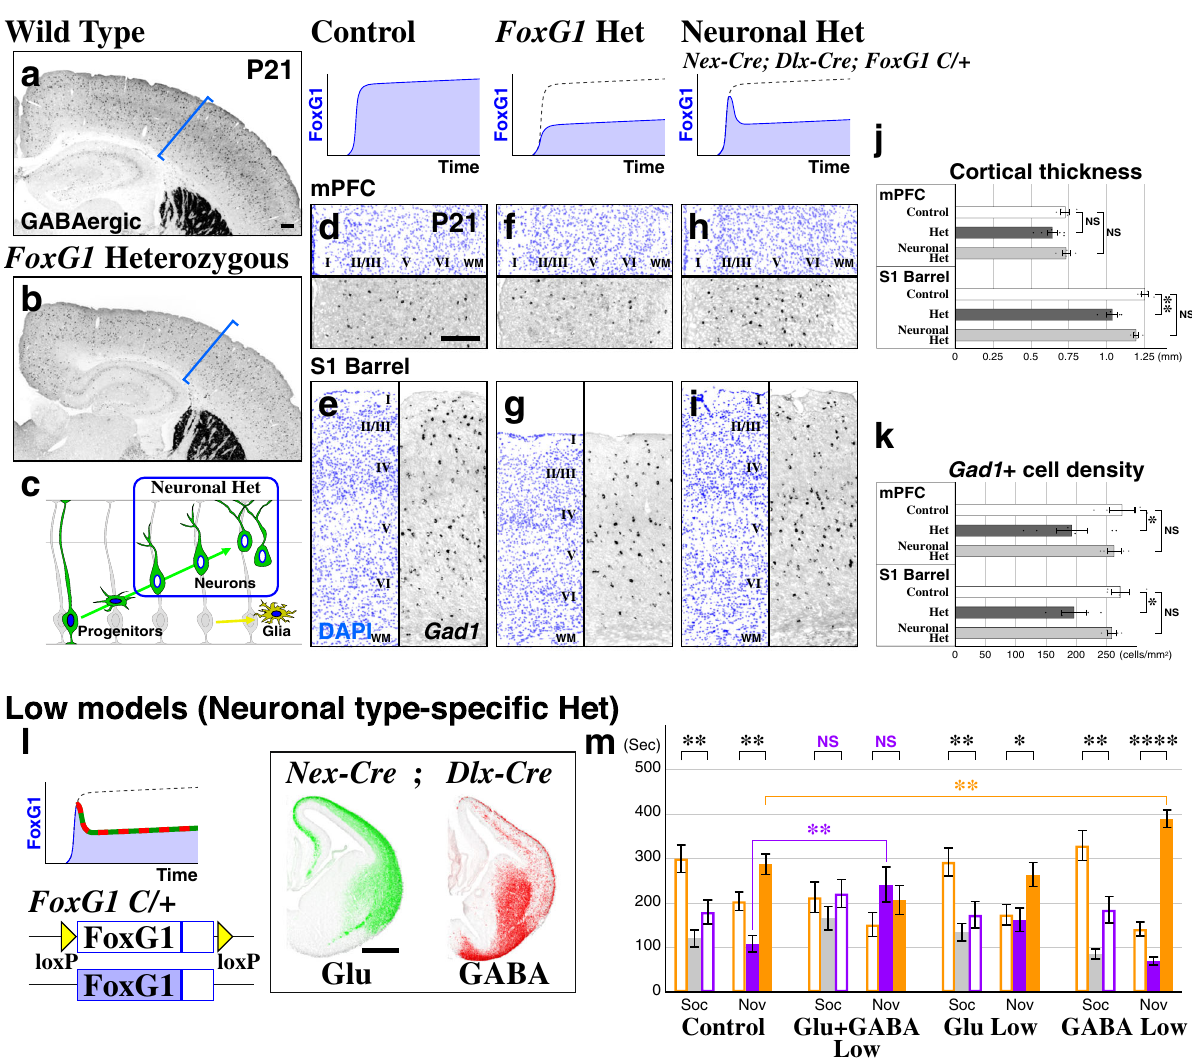
Fig. 2 ASD FOXG1 syndrome social phenotypes are due to neuronal FoxG1 haploinsuf fi ciency, but not microcephaly or loss of GABAergic cells. a , b Consistent with the microcephaly phenotypes found in human FOXG1 haploinsuf fi ciency patients, Heterozygous animals ( b ) exhibit a smaller brain size and reduced GABAergic cell numbers (labeled by Dlx5a-Cre ; Ai9 ) compared to wild type ( a ). Blue brackets indicate the thickness of the barrel cortex in wild type animals. c In the neuronal FoxG1 Heterozygous model, FoxG1 haploinsuf fi ciency only takes place in postmitotic neurons, thus sparing the progenitors and glia of the neocortex. d – i In situ hybridization with a Gad1 antisense probe (black) labels GABAergic cell populations, with DAPI stain (blue) to